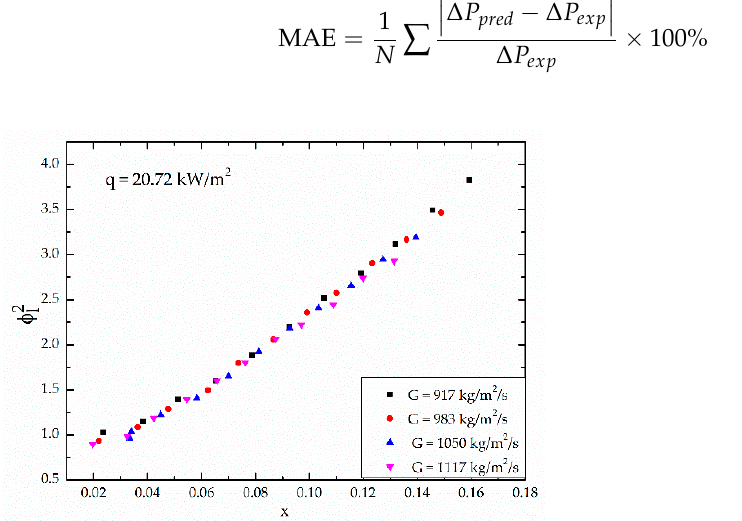
) with respect to the vapor quality under l